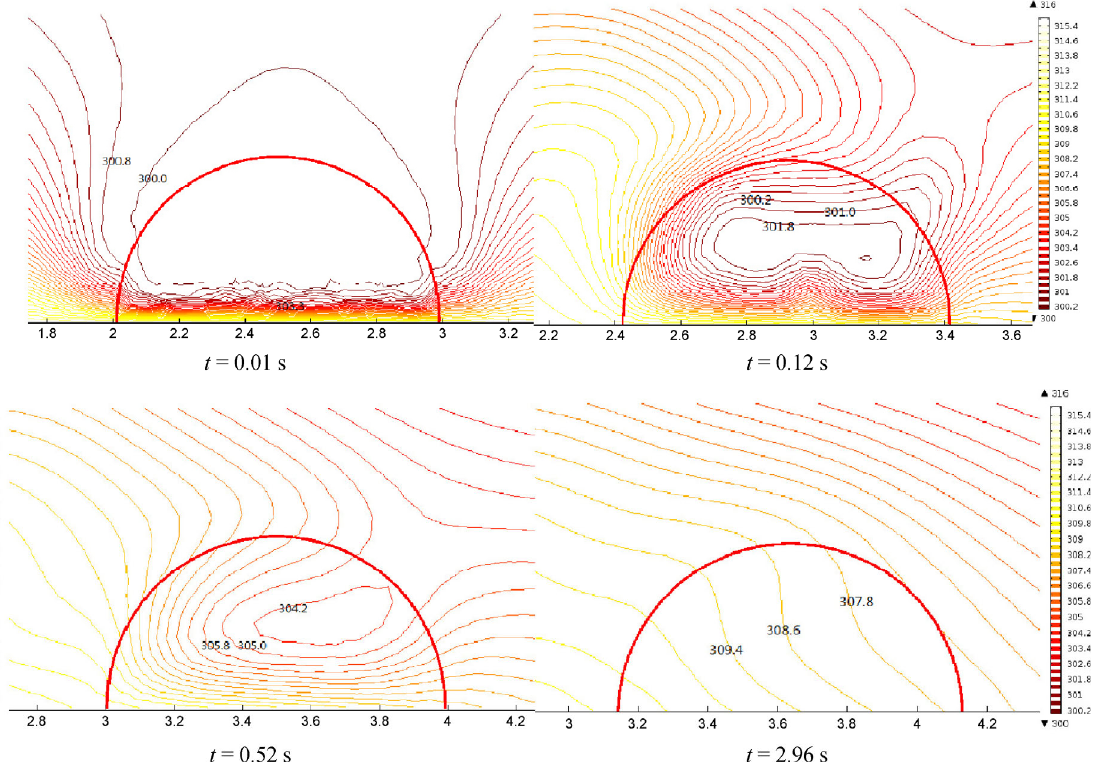
Fig. 4 Temperature T changes in silicone oil with time t at θ = 90° and G = 20